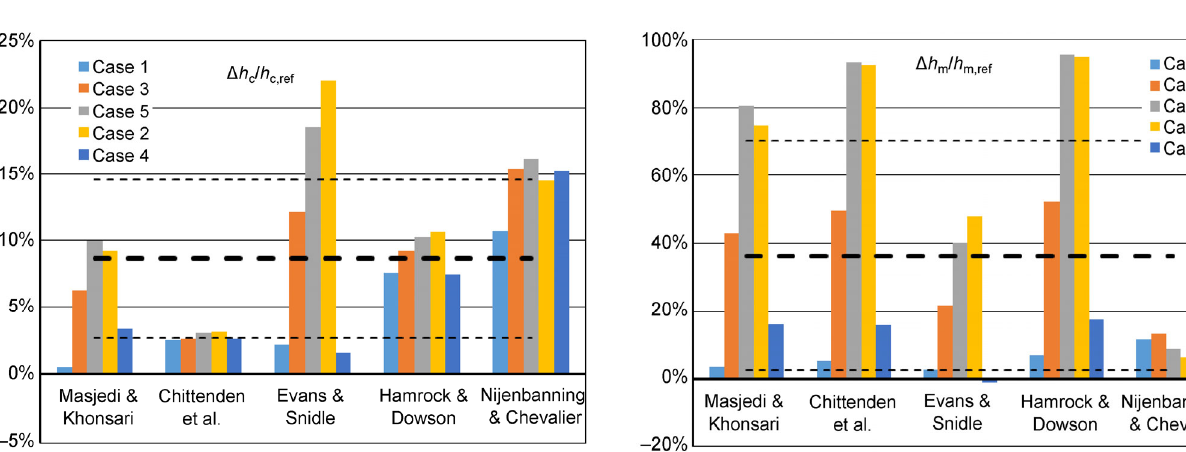
Fig. 2 Relative deviations given by analytical EHD film thickness expressions on h c , the central film thickness, for the 5 circular reference cases defined in Table 1.